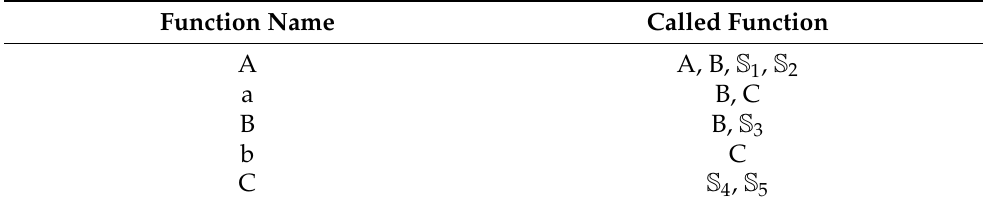
Table 5. The list of the functions in application and the called relationship by each function.